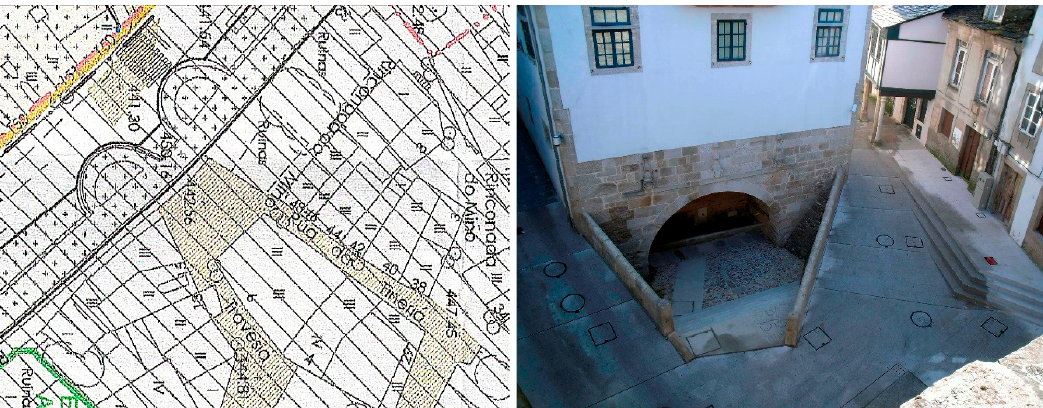
Figure 8. To the left , details of the General Town Planning Plan of Lugo. To the right , current appearance of the Porta Miñá Fountain from the area of the semi-cylindrical towers on the wall that flank its gate. The fountain is located between the wall and Calle de la Tinería and the current Travesía del Miño. Photgraphs were provided by the authors.